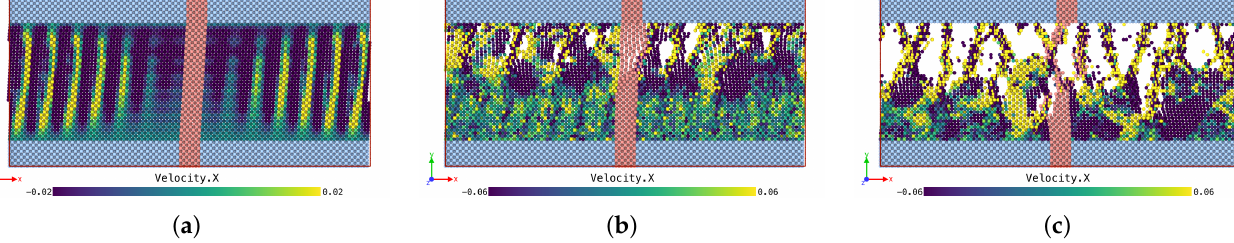
Figure 13. Set of particles tracked during the oscillatory test in a pure elastic substance. Example of a unstable case. Longitudinal waves above stability threshold. ( a ) t = 5.5 × 10 − 5 s. ( b ) t = 7.5 × 10 − 5 s. ( c ) t = 8.5 × 10 − 5